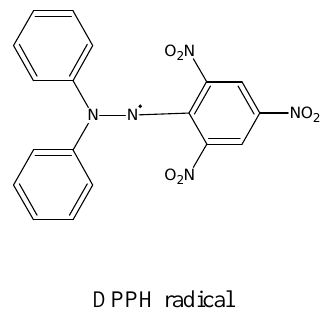
Ferricyanide method: Prussian